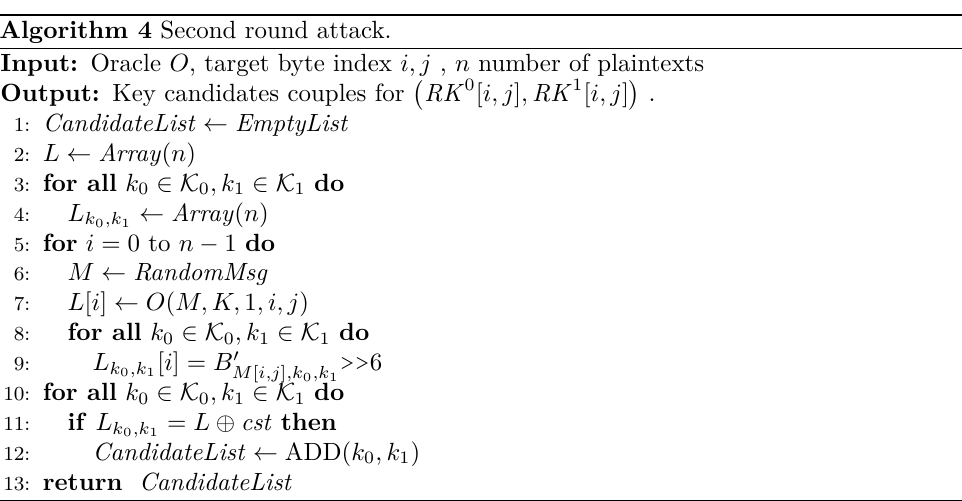
Algorithm 4 Second round